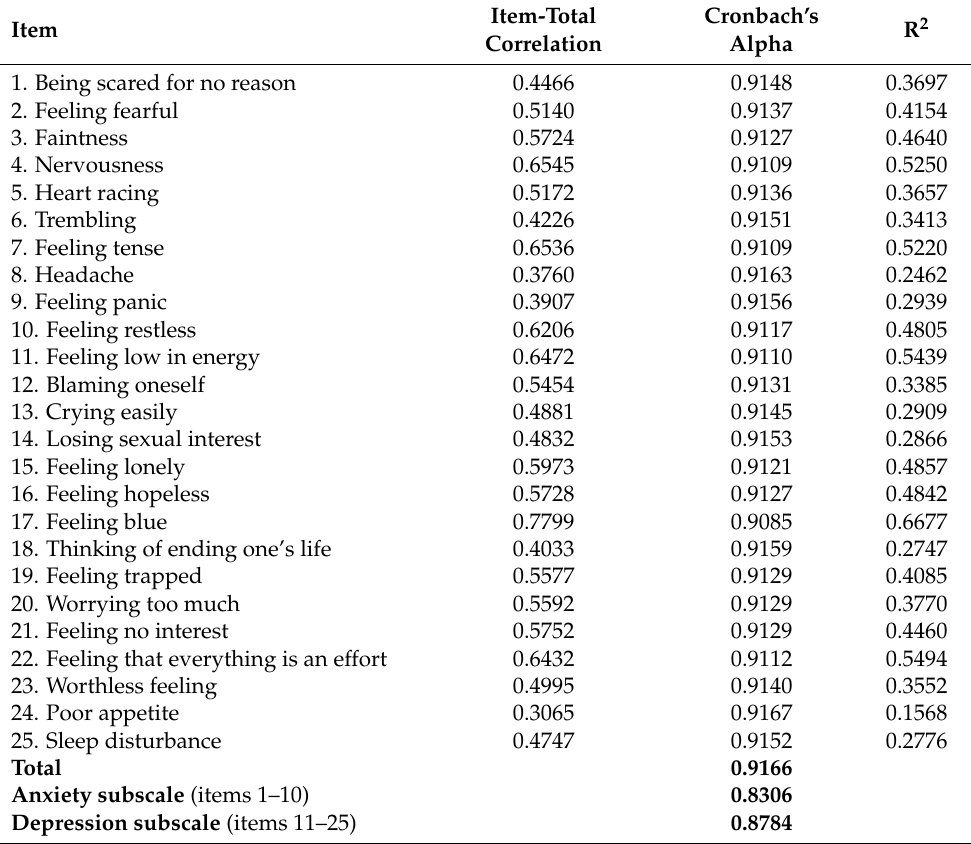
Table 6. Cronbach’s alpha coefficient of each item, globally and by